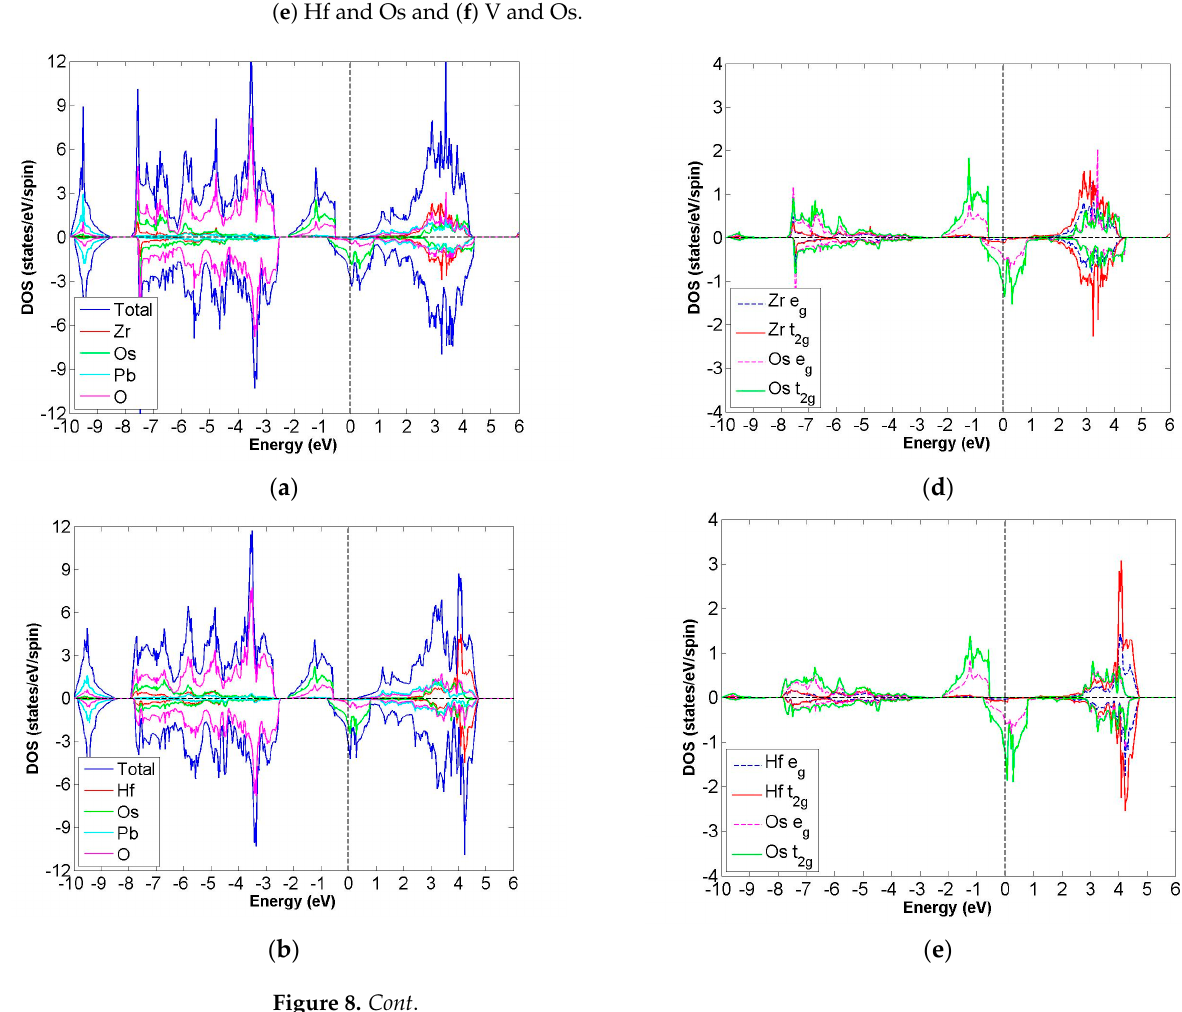
Figure 7. Based on the GGA calculation, the calculated total and partial DOS values of ( a ) Pb 2 ZrOsO 6 , ( b ) Pb 2 HfOsO 6 and ( c ) Pb 2 VOsO 6 and the partial DOS of e g and t 2g spin orbitals for ( d ) Zr and Os, ( e ) Hf and Os and ( f ) V and Os.